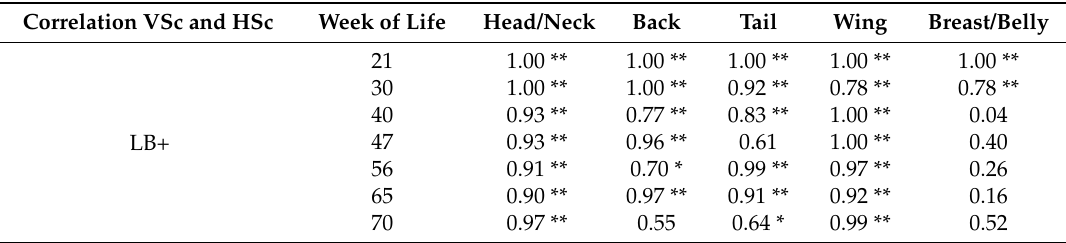
Table 3. Spearman’s rho and the level of significance for plumage score comparisons between VSc and HSc methods for individual body regions in LD laying hens (21st–70th week of life). Correlation VSc and HSc Week of Life Head/Neck Back Tail Wing